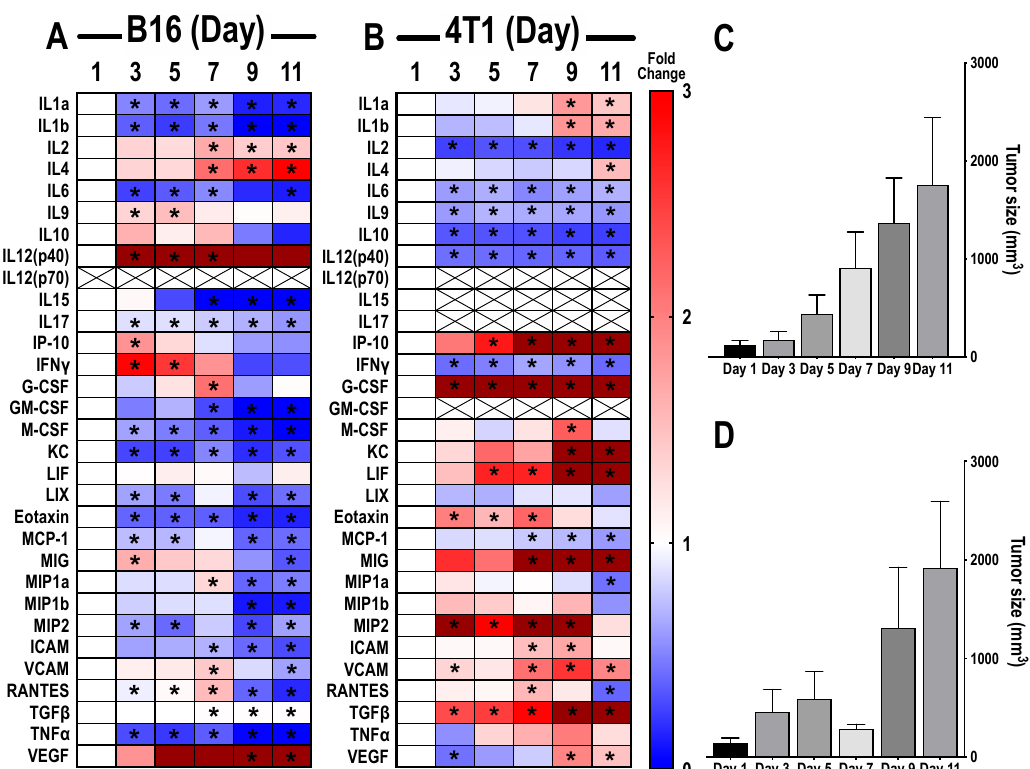
Figure 1. Proteomic changes of cytokines, chemokines, and trophic factors (CCTFs) over time in tumor microenvironment (TME) of mouse xenograft B16 melanoma ( A ) or 4T1 breast cancer ( B ). Heat maps depict the calculated ratio between the mean concentration of the detected CCTFs in each time point to the average concentration detected on day 1. Blue represents fold changes less than 1. Red represents 1–3 fold changes. Dark red represents fold changes > 3.1. Asterisks indicate statistical significance ( p < 0.05) identified by one-way analysis of variance (ANOVA) test; tumor size volumes of mouse xenograft B16 melanoma ( C ) or 4T1 breast cancer ( D ) models were determined 3, 5, 7, 9, and 11 days after reaching ~5 mm size in diameter (day 1 tumors).